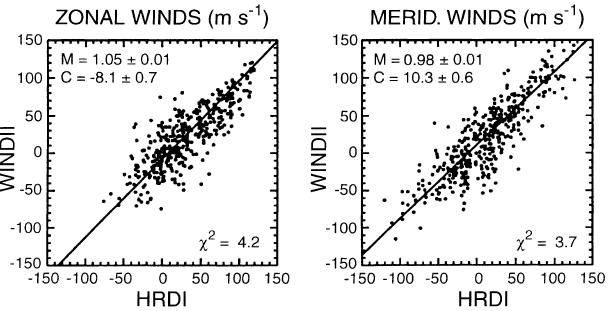
Fig. 1. Scatter plot of WINDII and HRDI zonal and meridional winds for all coincident measurements at an altitude of 95 km (total of 412) occurring on 17 January 1993